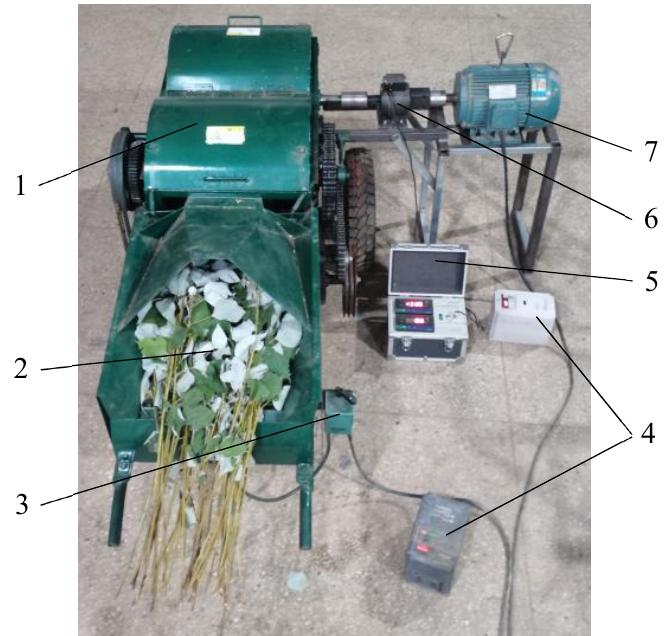
Figure 8. Chopping system performance test bench: 1. chopping system; 2. ramie stalk; 3. motor switch of feeding part; 4. frequency converter; 5. agricultural machinery torque and speed tester; 6. torque sensor; and 7. control motor of chopper.